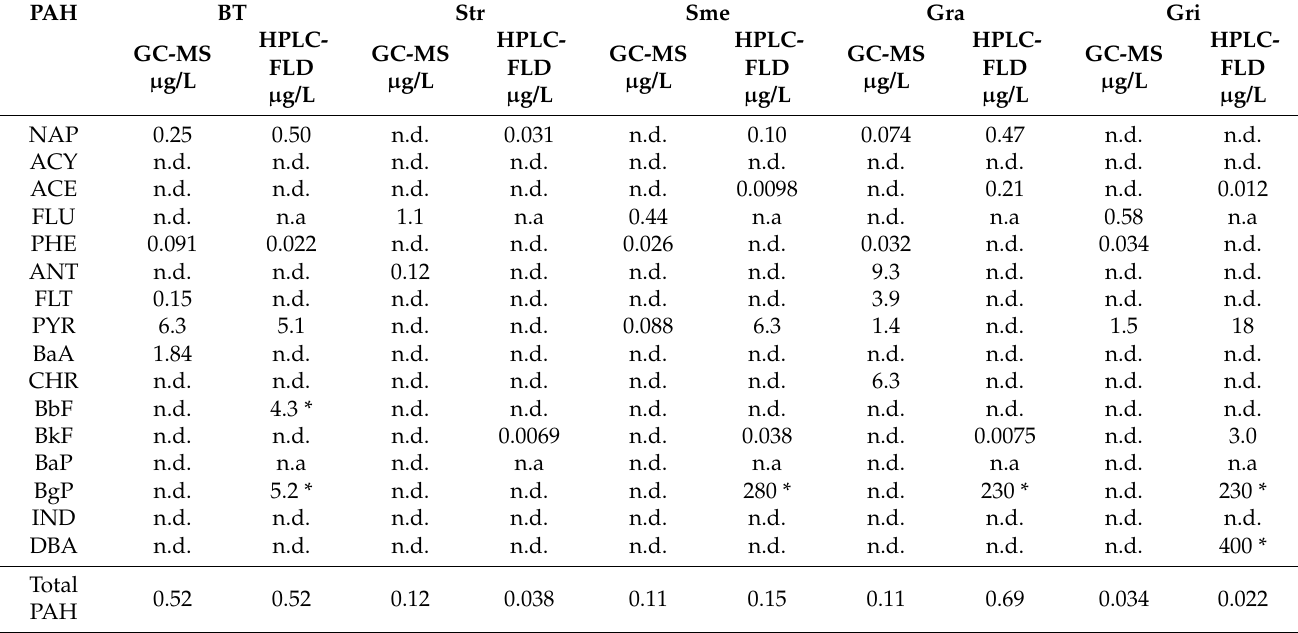
Table 3. Detected total concentrations ( µ g/L) of 16 PAH compounds in tunnel wash water samples from 5 different tunnels in Norway (BT = Bjørnegård tunnel; Str = Strindheim tunnel; Sme = Smestad tunnel; Gra = Granfoss tunnel; Gri = Grillstad tunnel). n.d. = not detected, n.a = not analyzed, and * indicates values that are false